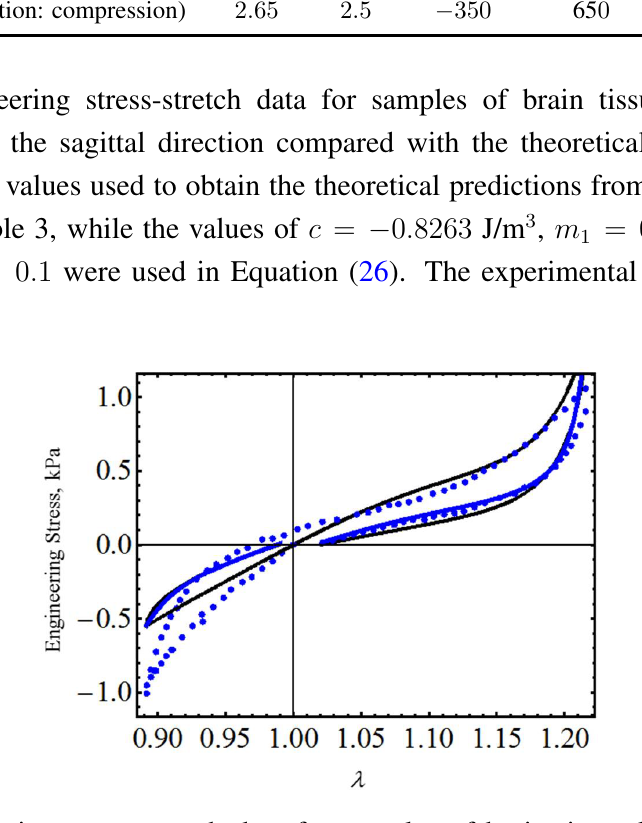
Figure 8. Engineering stress-stretch data for samples of brain tissue harvested from the occipital lobe in the frontal direction compared with the theoretical predictions.